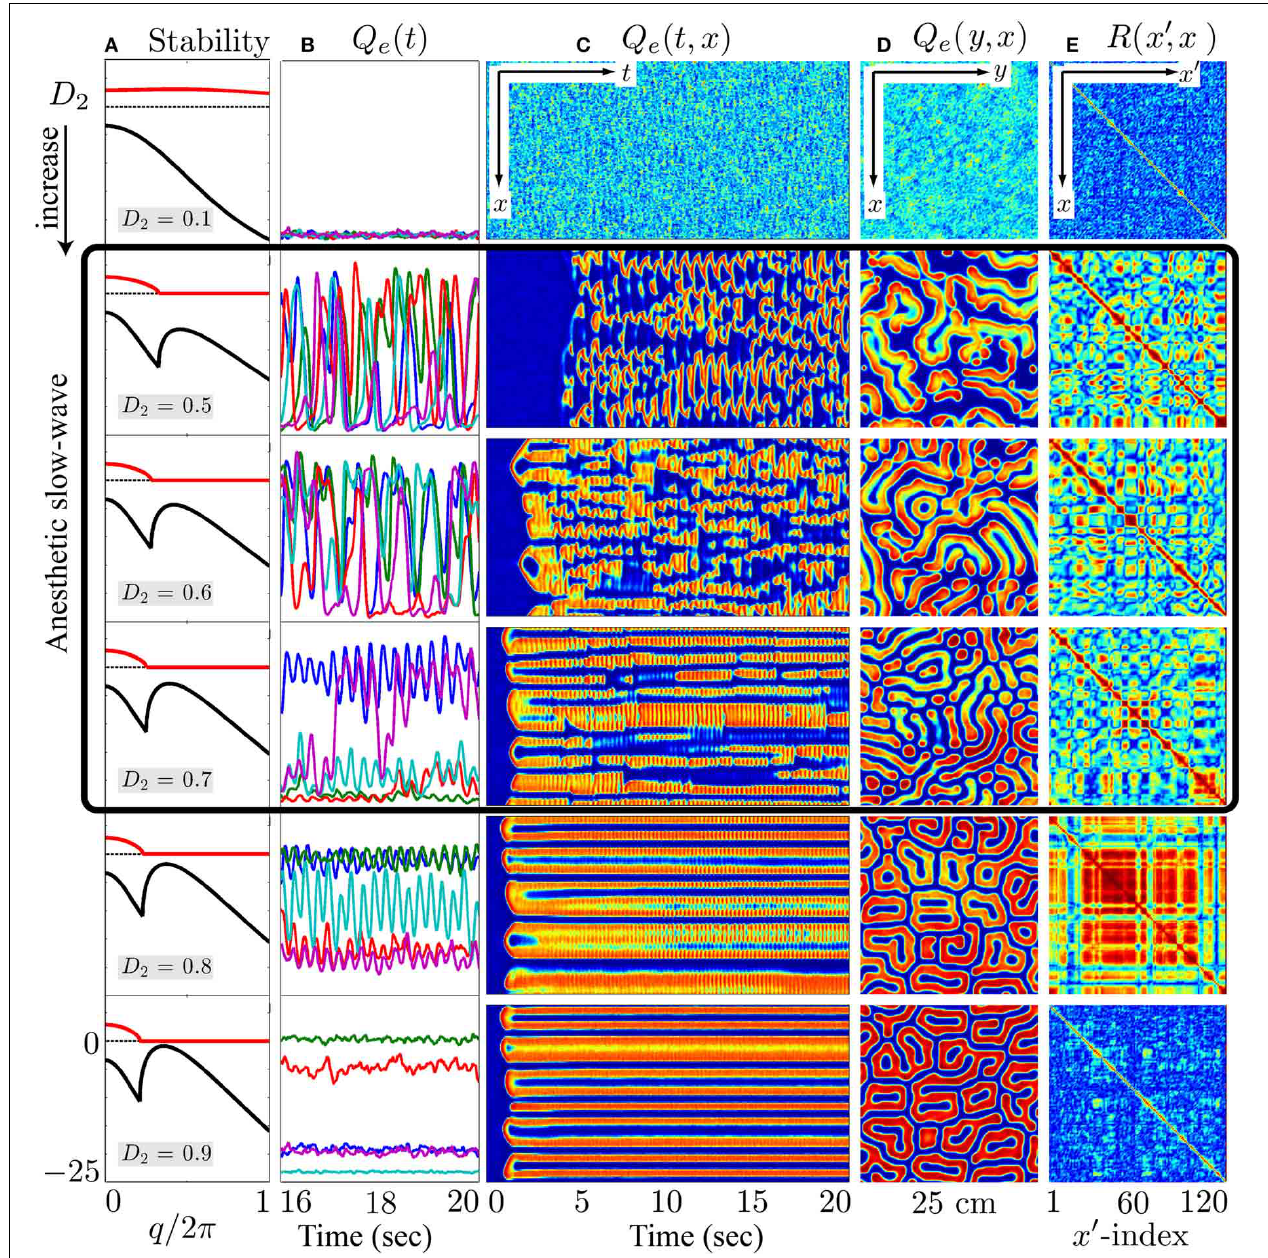
Q e ( t ) extracted from 5 equal-spaced grid-points in (C) Q e ( t , x ) space-time chart representing the full 20-s time-evolution of cortical activity along the y = 60 midline strip. (D) Bird’s-eye snapshot Q e ( y , x ) of the cortex when t = 20s. (E) Phase coherence map R ( x (cid:8) , x ) showing synchronization level of firing-rate between Q e ( t , x ) and Q e ( t , x (cid:8) ) for the final 5-s time evolution. In (C–E) , color scale from blue to red indicates the numerical range from low to high. (Figure modified from Steyn-Ross et al.,